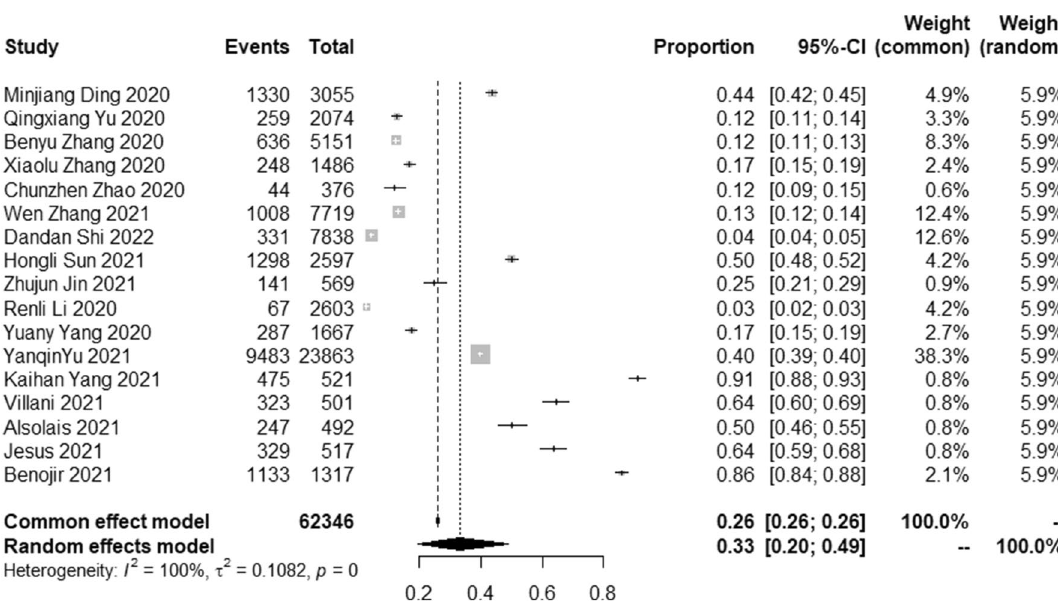
Figure 5. Forest plot of the meta-analysis on prevalence rates of fear symptoms in the student